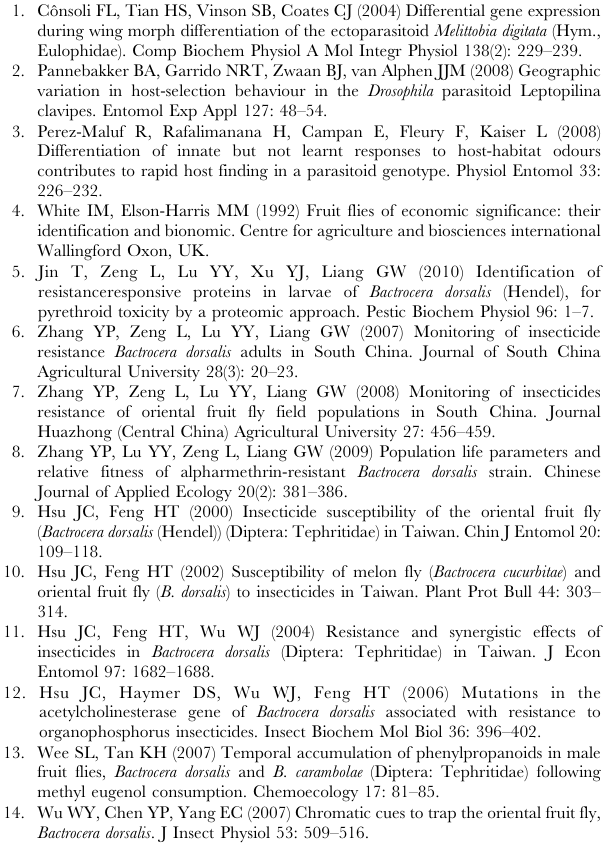
Table S1 The annotation of all assembly transcripts in